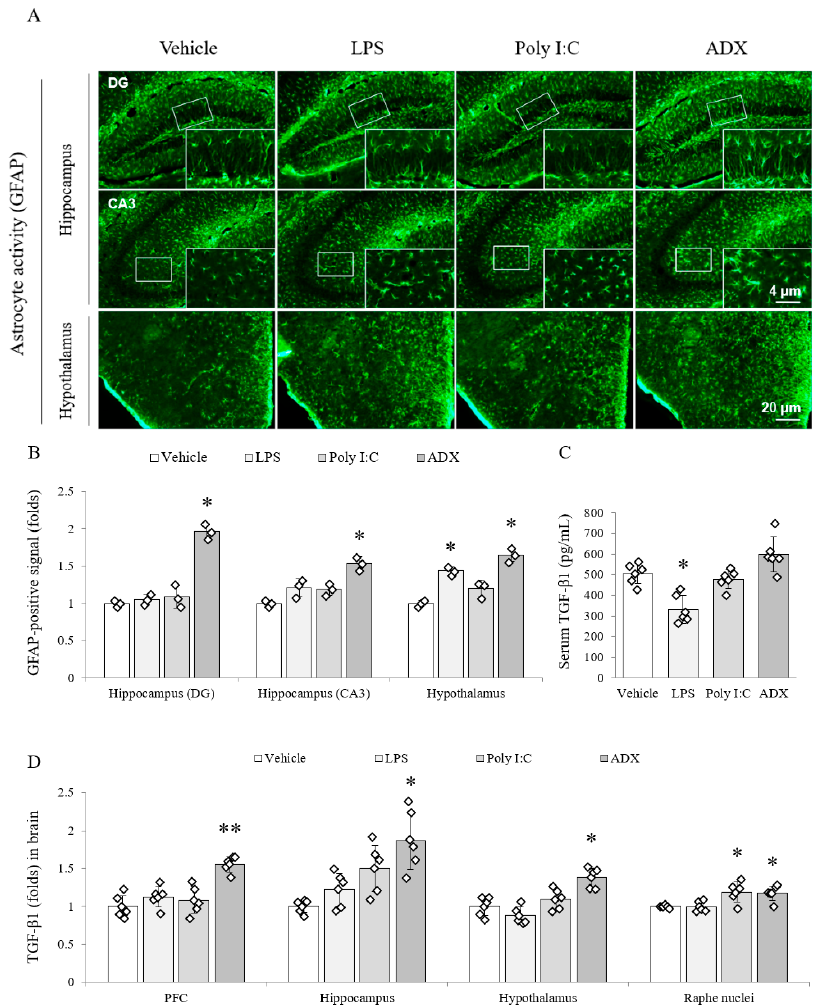
Figure 2. Astrocyte activity and TGF- β 1 expression in both brain regions and serum. GFAP-positive stained astrocytes in hippocampal subregions and the hypothalamus ( A ). Representative photomicrographs were taken at magnifications of 100 × and 500 × . Quantification of astrocyte activity in brain regions ( B ). Active form of TGF- β 1 in serum ( C ) and brain regions ( D ). Data are expressed as the means ± SD ( n = 6). *, p < 0.05; **, p < 0.01 compared with the vehicle group. DG; dentate gyrus, CA3; cornu ammonis3, TGF- β 1; transforming growth